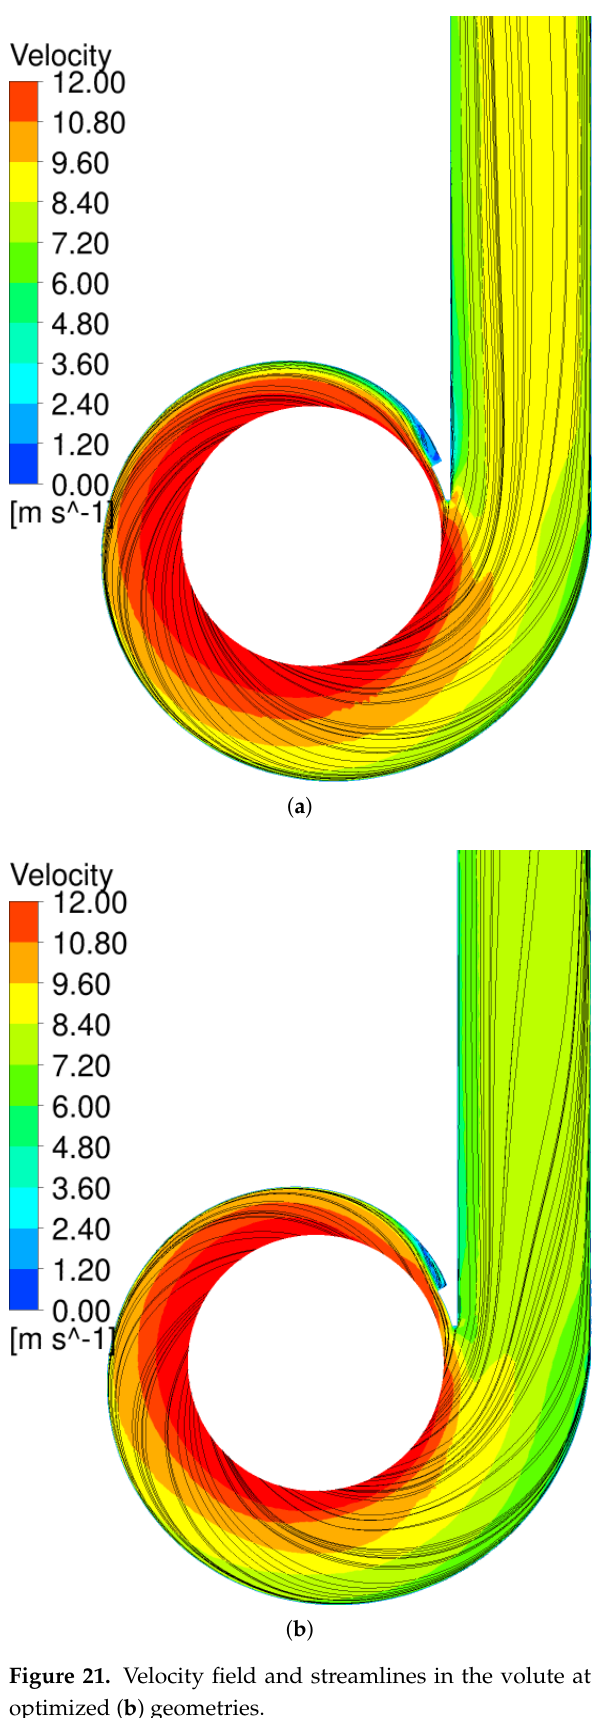
Figure 21. Velocity field and streamlines in the volute at z = 4 mm for the baseline ( a ) and the optimized ( b )